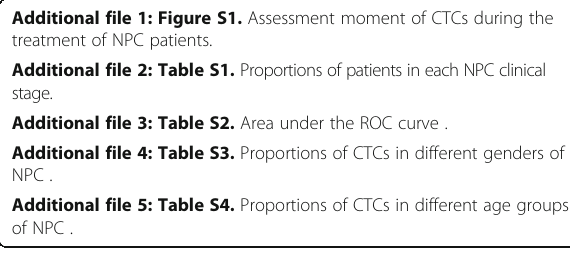
Additional file 1: Figure S1. Assessment moment of CTCs during the treatment of NPC patients. Additional file 2: Table S1. Proportions of patients in each NPC clinical stage. Additional file 3: Table S2. Area under the ROC curve .